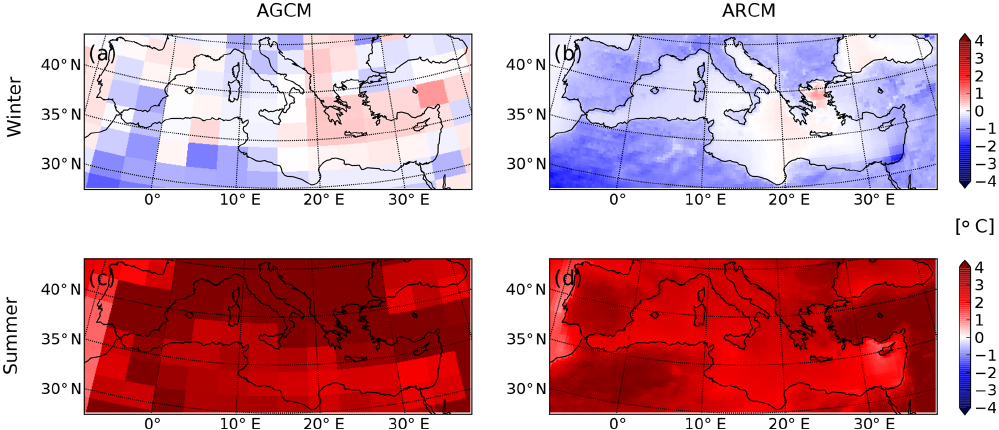
Figure 8. Deviations (EHOL–PICTRL, averaged over the entire simulation) of surface air temperature at 2m for winter (a, b) and summer (c, d) , respectively. AGCM (LMDZ-global) is displayed in panels (a) and (c) and ARCM (LMDZ-regional) in panels (b) and (d)